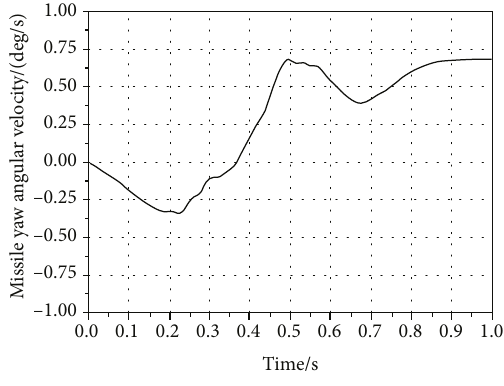
Figure 23: Yaw angular velocity curve.